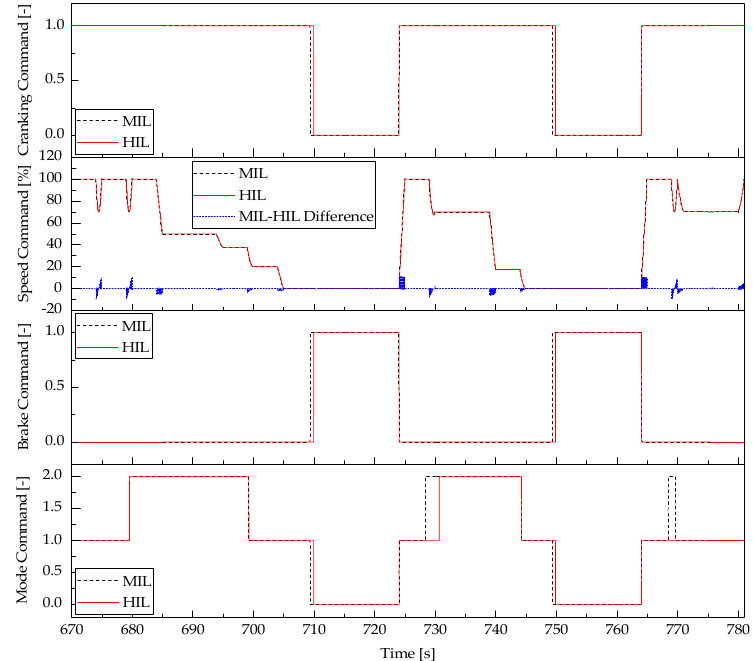
Figure 12. Comparison of PISSC outputs of MIL and HIL tests during cycle 7-th.